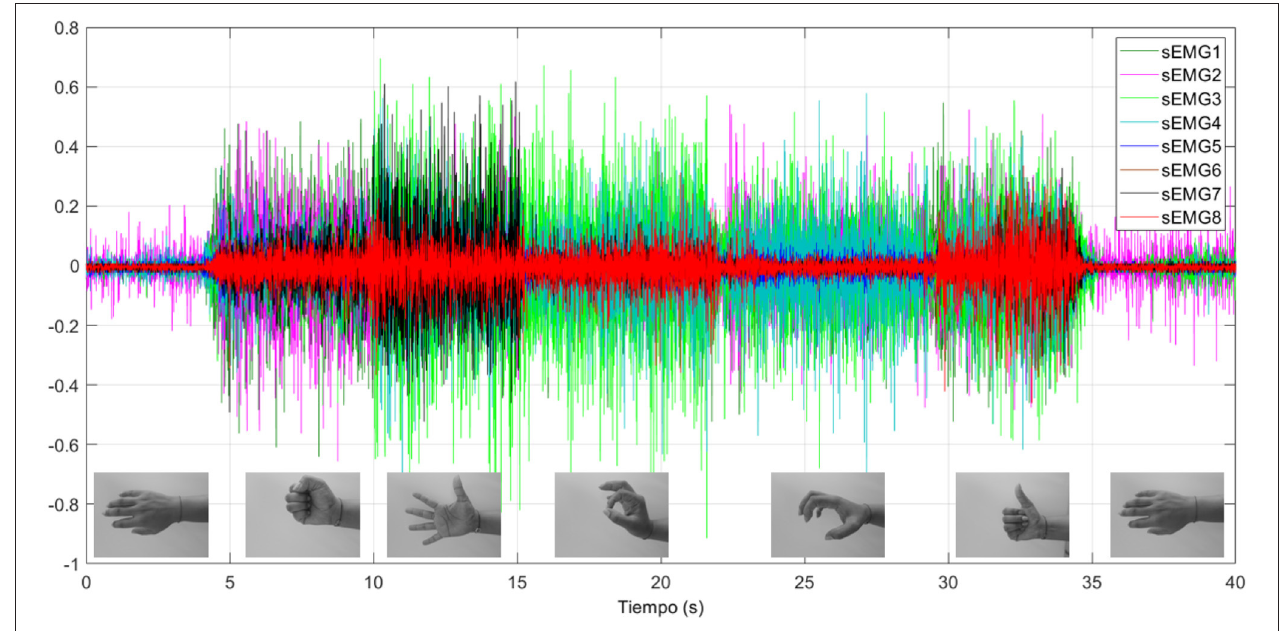
FIGURE 10 | sEMG signals for the eight sensors for the gestures tested.